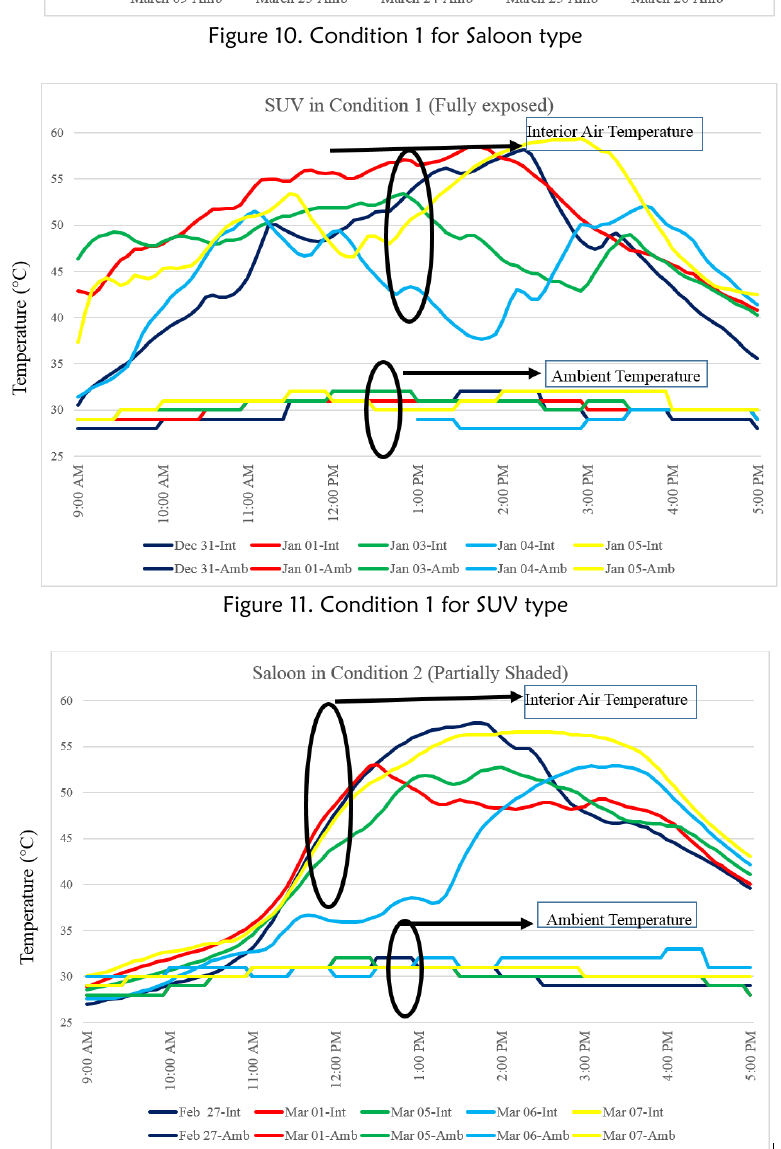
Figure 12. Condition 2 for Saloon